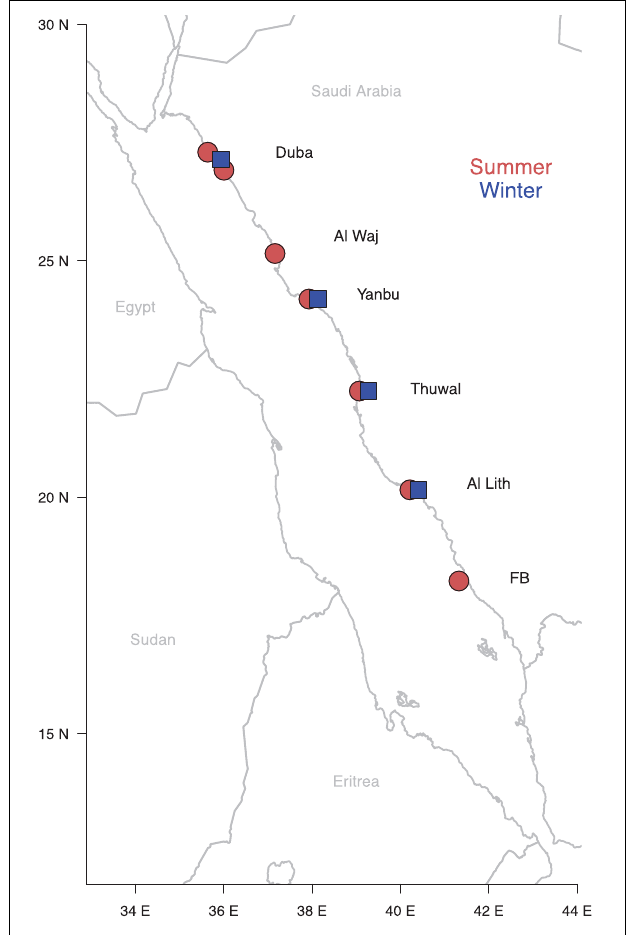
FIGURE 1 | Map showing the location of the eight seagrass meadows surveyed. The Farasan Banks were indicated as FB. The blue squares and red dots represent the meadows surveyed in the winter and summer of 2017, respectively. For additional information on the study sites see